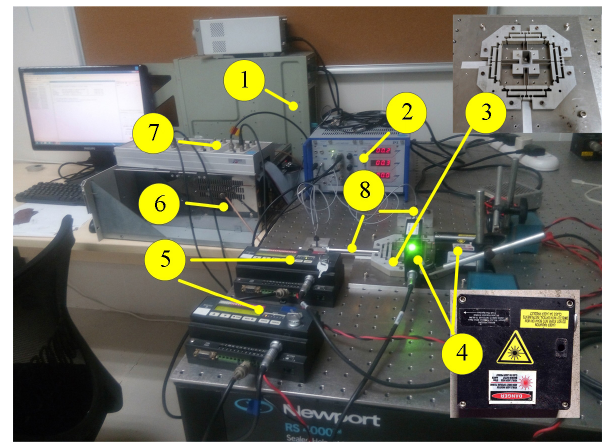
Figure 14. The experimental setup. (1) Host computer, (2) signal amplifier and controller, (3) compliant mechanism, (4) laser sen- sors, (5) laser collectors, (6) dSPACE controlling system, (7) DAQ board, (8) PZT